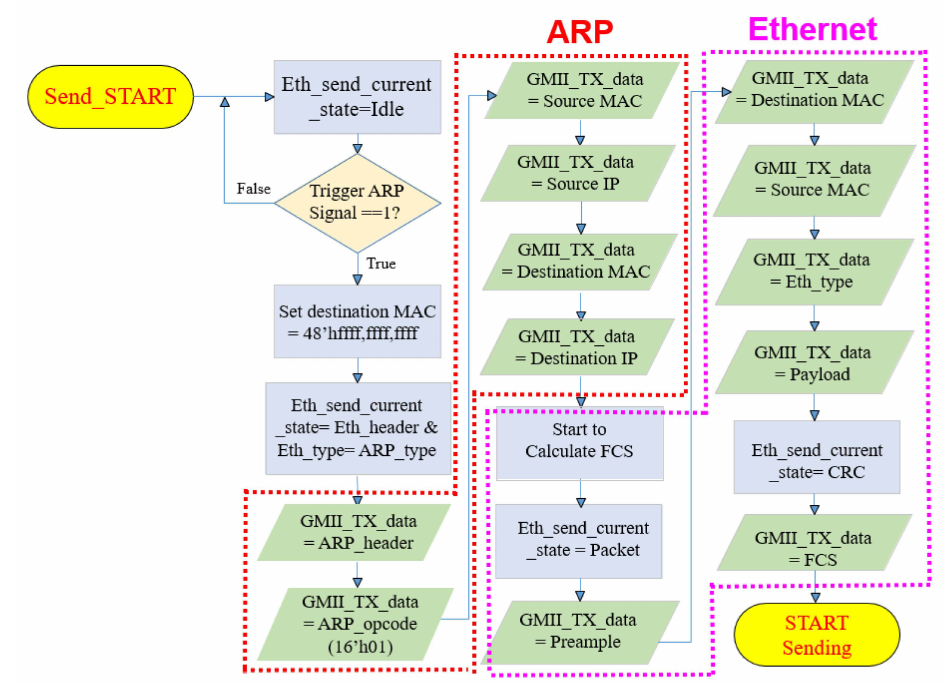
Figure 5. Flowchart of the Request packet transmitted from the submodule ARP_send_module to external device to obtain the MAC address of external device.